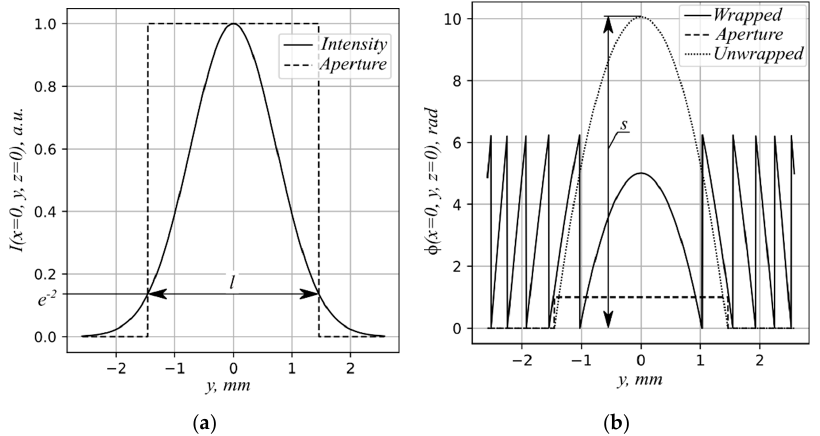
Figure 3. ( a ) Determination of the chord length l from the intensity of the modeled wave by level I max /e 2 for the synthesis of the aperture. ( b ) Overlay an aperture on a wrapped phase to obtain an unwrapped phase.